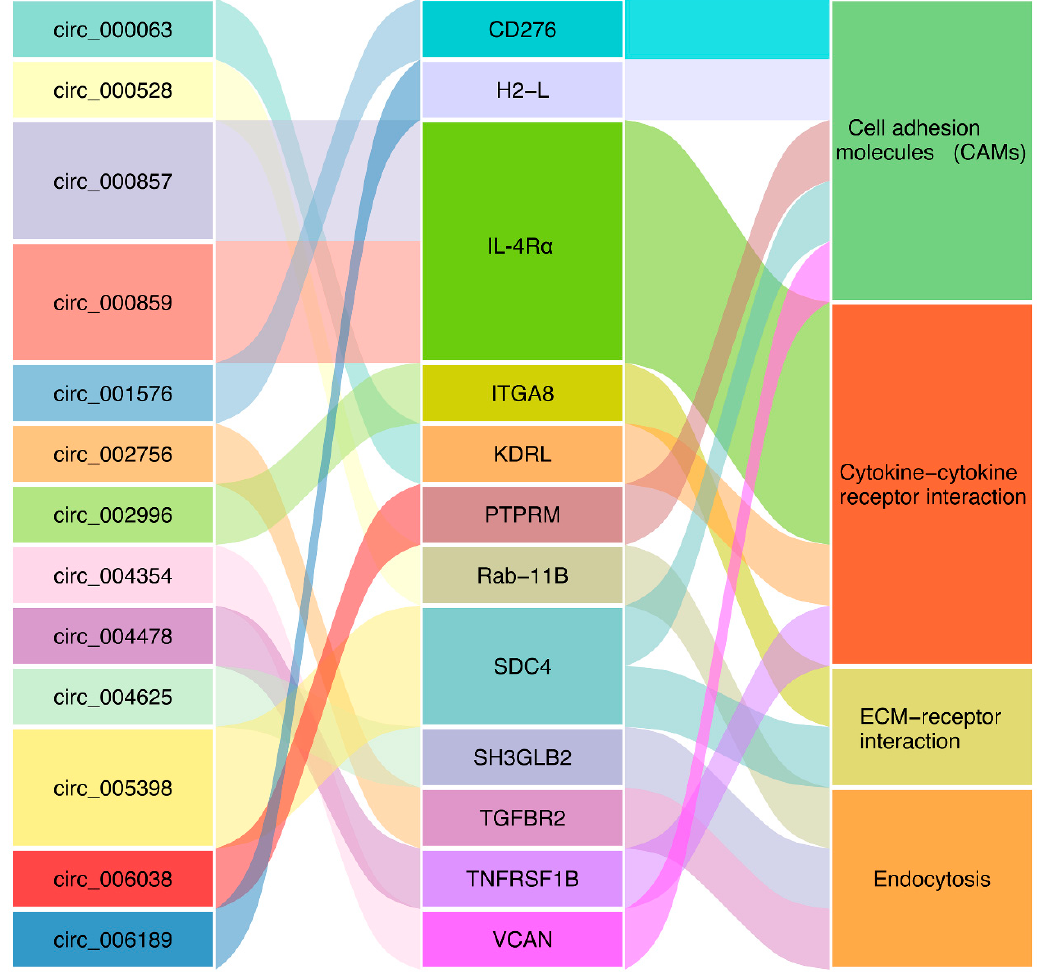
Figure 5. DEcirs and the corresponding parental genes associated with four immune-related pathways. CD276 , CD276 antigen; H2-L , H-2 class I histocompatibility antigen, α chain-like; IL-4R α , interleukin-4 receptor subunit α ; ITGA8 , integrin α 8; KDRL , vascular endothelial growth factor receptor kdr-like; PTPRM , receptor-type tyrosine-protein phosphatase mu-like; Rab-11B , ras-related protein Rab-11B; SDC4 , syndecan-4-like; SH3GLB2 , SH3 domain containing GRB2 like, endophilin B2; TGFBR2 , TGF- β receptor type 2; TNFRSF1B , tumor necrosis factor receptor superfamily member 1B; VCAN , versican core protein.